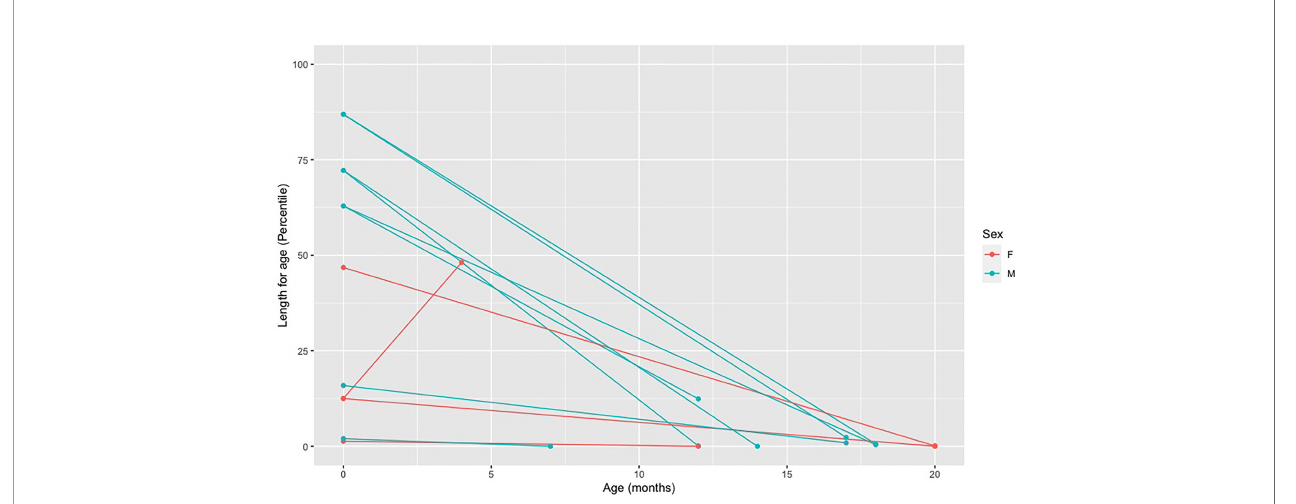
FIGURE 3 | Decreased in length percentile from birth to diagnosis in affected individuals. Each point represents a length measure in percentile taken at a different age. The fi rst dot (far left) represents the length at birth and the second dot represents the length at the age of diagnosis. The two dots of each individual are connected by a